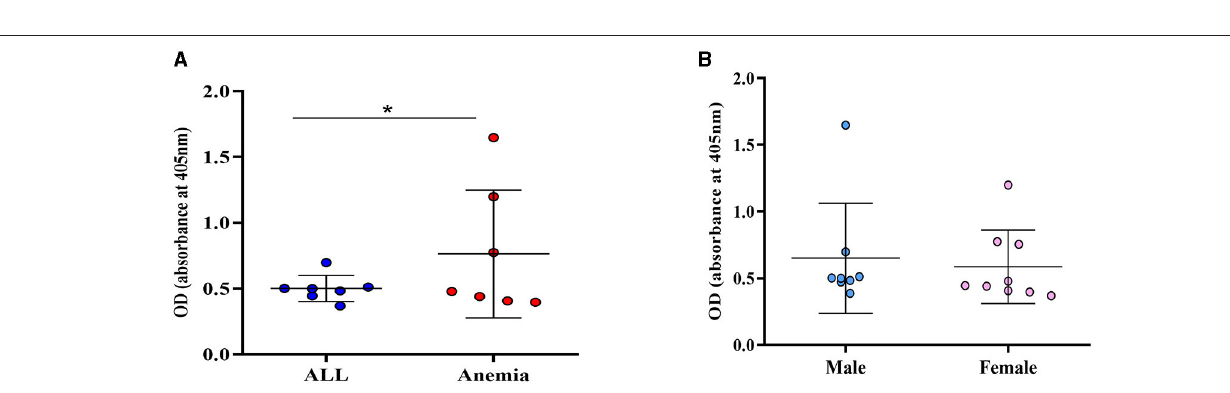
FIGURE 3 | Variance of CMV IgM Ab positivity. (A) OD levels between patients with ALL and anemia; (B) OD-values according to sex; * p = 0.001 ( F